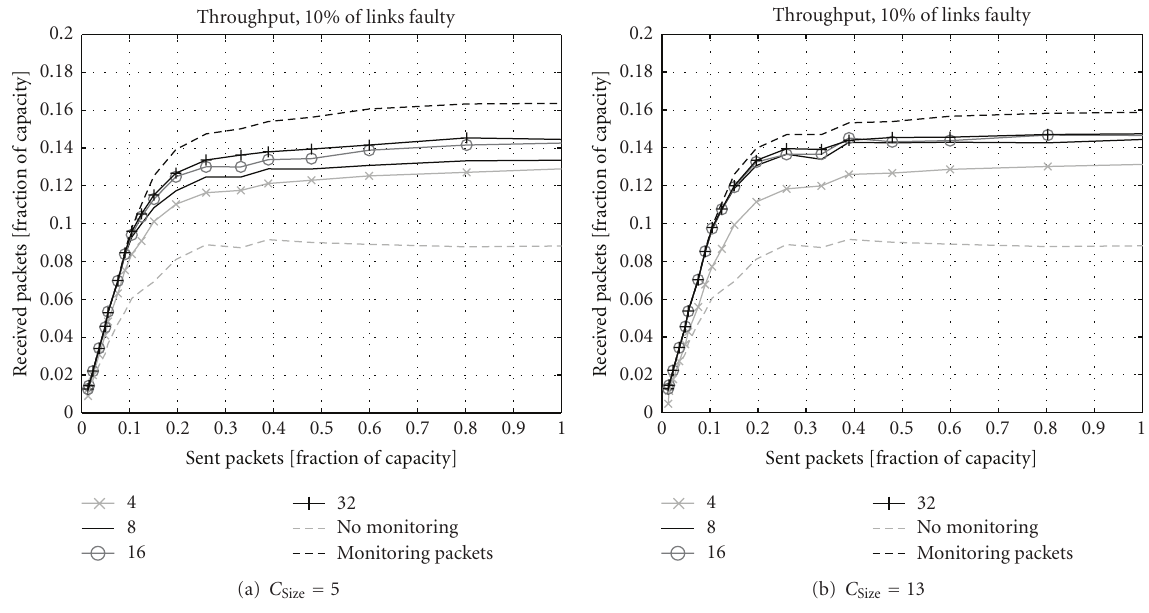
Figure 13: Throughput with di ff erent granularity alternatives using serial communication. 10% of links are faulty and data processing is